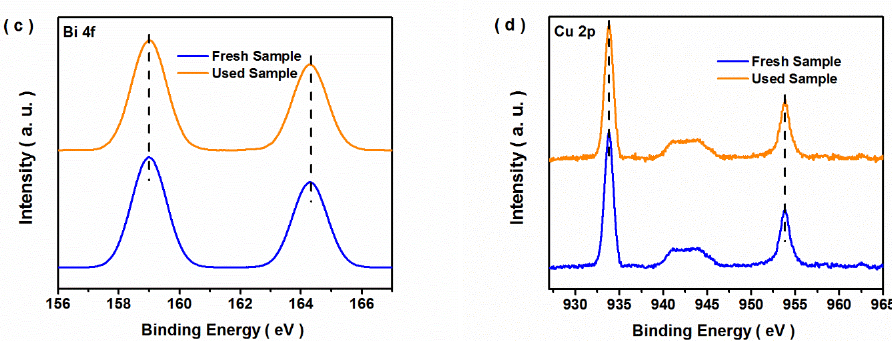
Figure 5. Photocatalytic activity ( a ) of 30CBO/CuO in the cycling experiment; ( b ) XRD pattern, ( c ) Bi 4f and ( d ) Cu 2p XPS spectra of the fresh and used 30CBO/CuO samples after the sixth cycling experiment.